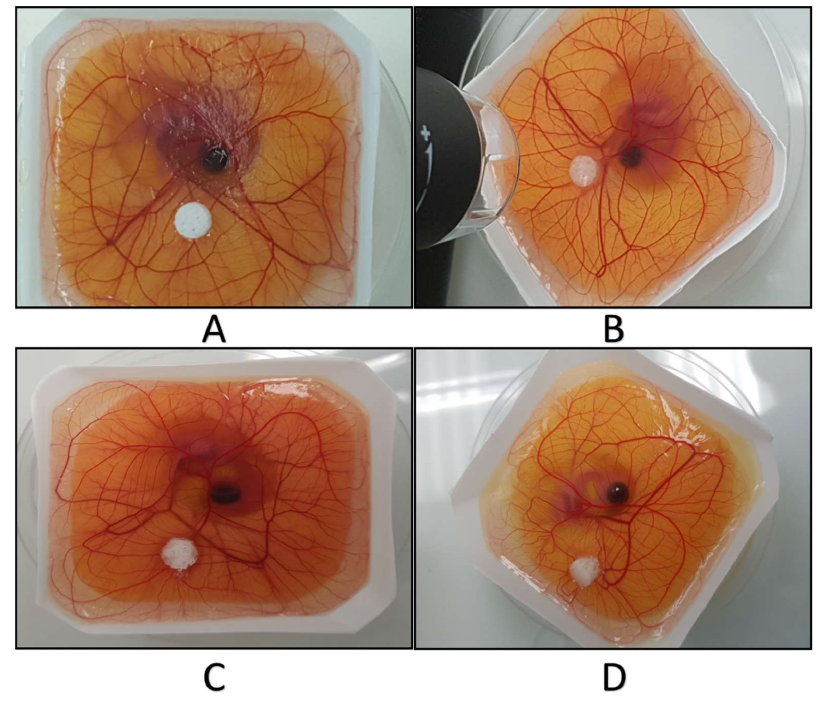
Figure 13. CAM Assay experiments, ( A , B ) PU scaffold of two different samples. ( C , D ) PU/HA scaffolds of two different samples.